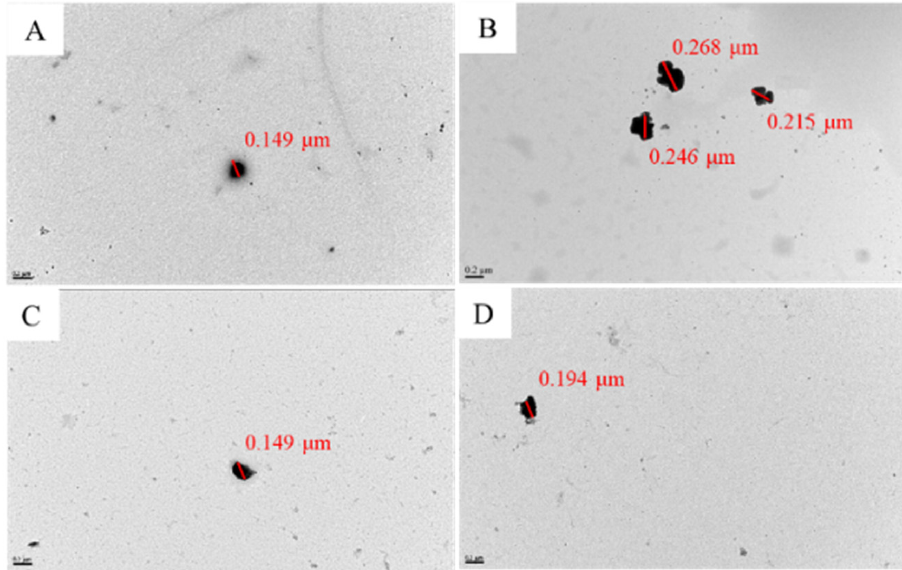
Figure 2. TEM images of EDA-BCD ( A ), TEPA-BCD ( B ), TEPA-BCD/plasmid DNA ( C ), and TEPA-BCD/siRNA ( D ). The ratios of TEPA-BCD/plasmid DNA and TEPA-BCD/siRNA are 1.28:1 and 96.54:1 ( w / w ). The scale bar is 0.2 μ m.